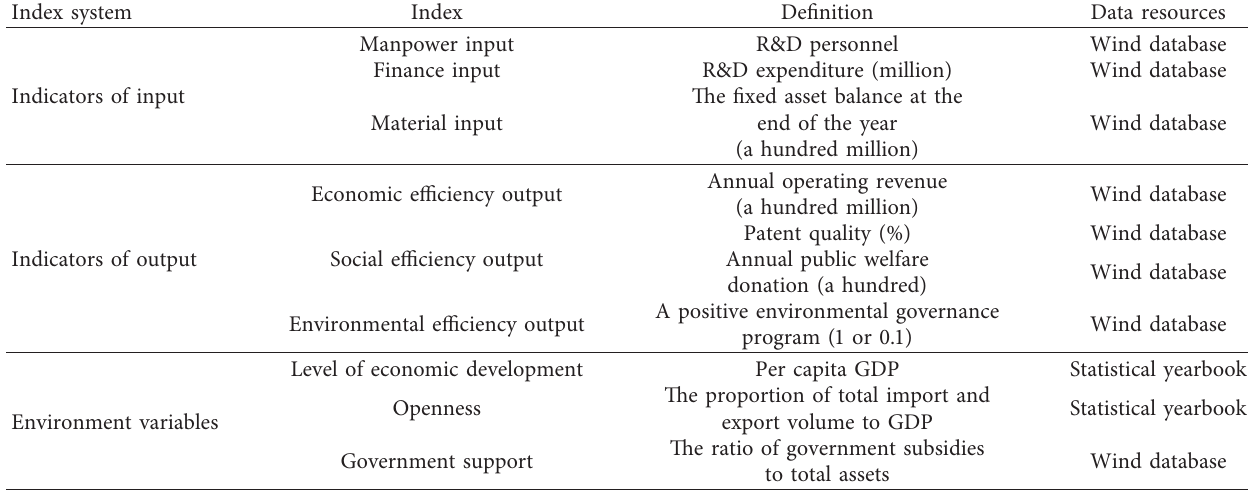
Table 1: Index system of green innovation efficiency measurement of listed energy companies in